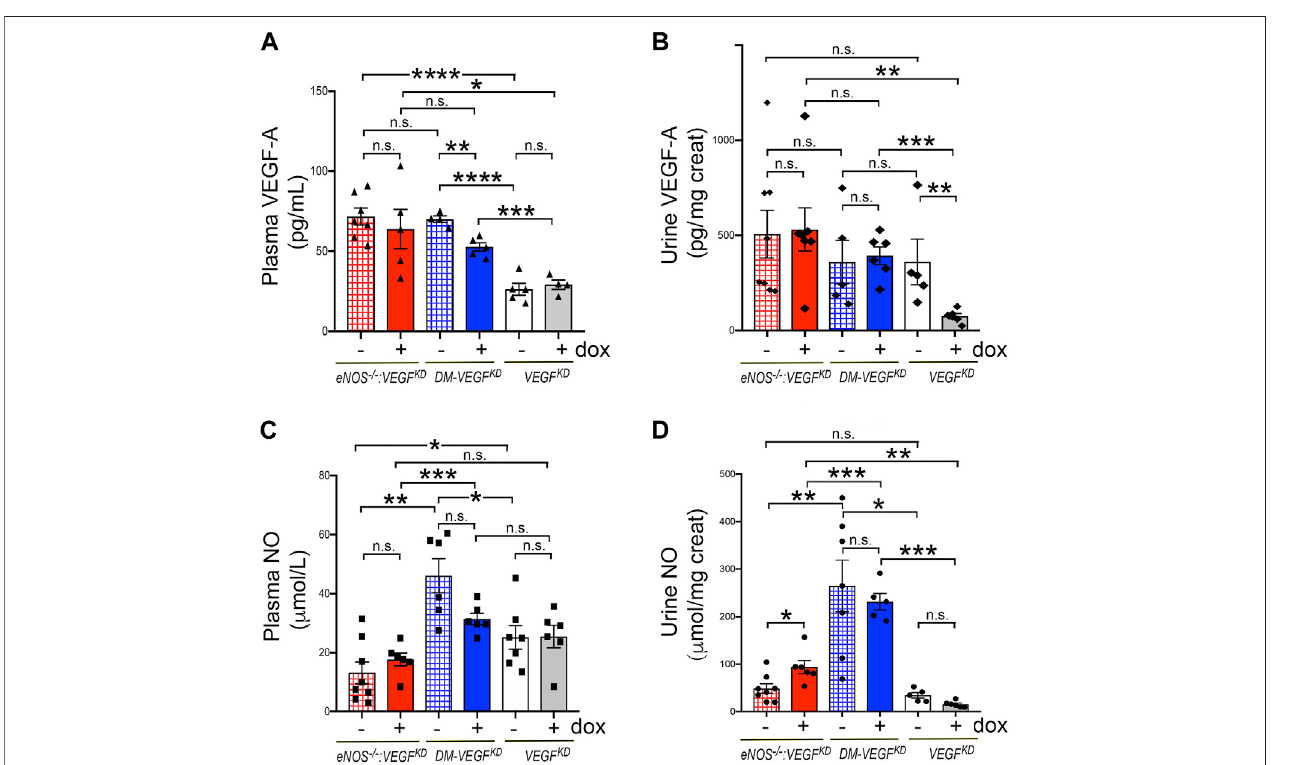
FIGURE6| Effectof VEGF KD oncirculatingandurineVEGF-AandNOindiabeticand eNOS − / − :VEGF KD mice. (A) plasmaVEGF-Aissimilarlyelevatedin eNOS − / − :VEGF KD mice (red bars) irrespectively of VEGF KD , as compared to non-diabetic eNOS intact mice ( VEGF KD − dox, white bar) (****, p = < 0.0001) or VEGF KD + dox mice (gray bar) (*, p < 0.005); in diabetic mice VEGF KD (DM- VEGF KD + dox, blue bar) signi fi cantly decreases circulating VEGF-A (**, p = 0.0013), but all diabetic mice have plasma VEGF-A > 2-fold higher than non-diabetic mice with intact eNOS ( VEGF KD , white/gray bars) (****, p < 0.0001 and ***, p = 0.0006). (B) Urine VEGF-A: podocyte VEGF KD doesnotalterVEGF-Aexcretionin eNOS − / − :VEGF KD (redbars)ordiabeticmice(bluebars); VEGF KD signi fi cantlyinhibitsVEGF-Aexcretioninnon- diabetic mice ( VEGF KD + dox, gray bar) (**, p = 0.0043). (C) Plasma NO: podocyte VEGF KD (+ dox) does not signi fi cantly alter plasma NO in any experimental group; plasmaNOislowerin eNOS − / − :VEGF KD (redbars)thandiabetic(bluebars)(**, p =0.001and***, p =0.0009) and non-diabeticmicewith intact eNOS (white bar) (*, p = 0.047); plasma NO is higher in diabetic (DM- VEGF KD − dox, hatched blue bar) than in non-diabetic mice ( VEGF KD − dox, white bar) (*, p = 0.015) and VEGF KD abrogates this change (DM- VEGF KD + dox, blue bar). (D) Urine NO: VEGF KD increases NO excretion in eNOS − / − :VEGF KD + dox mice (*, p = 0.0272, red bar); all diabetic mice (blue bars) have several fold higher NO excretion than non-diabetic mice (white/gray bars), irrespectively of VEGF KD